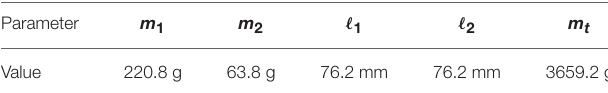
FIGURE 5 | (A) A schematic of the experimental setup comprising a shaker, cart and the pendulum chain with periodic mass (linkage) variations carrying a payload. (B) Evolution of poles as a function of the ratio ̺ and a close-up of pole distribution at ̺ numerical transfer functions of the even-numbered masses starting at i TABLE 2 | A summary of the system parameters used in the experimental